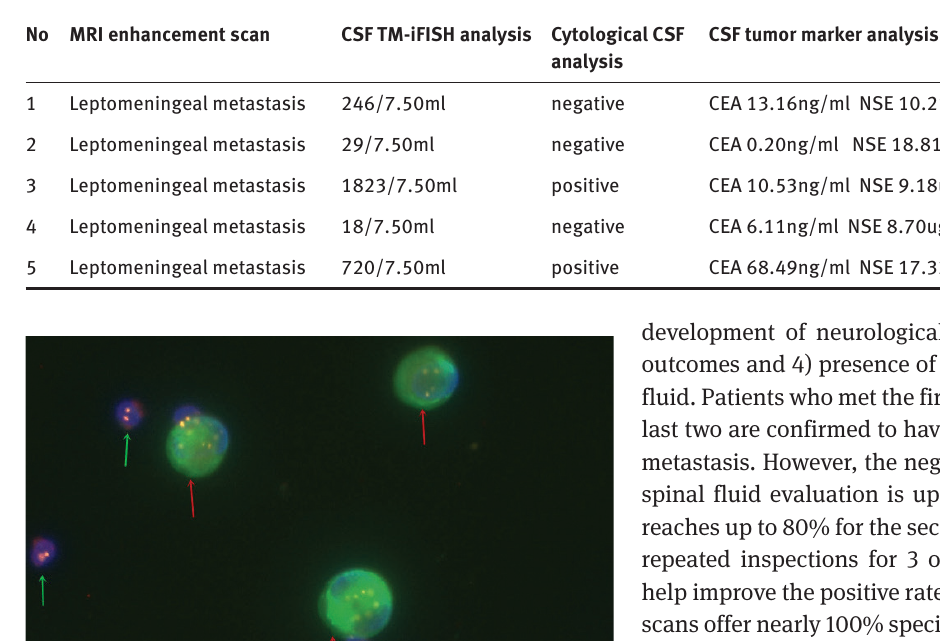
Table 2: The results of the different testing methods for 5 patients